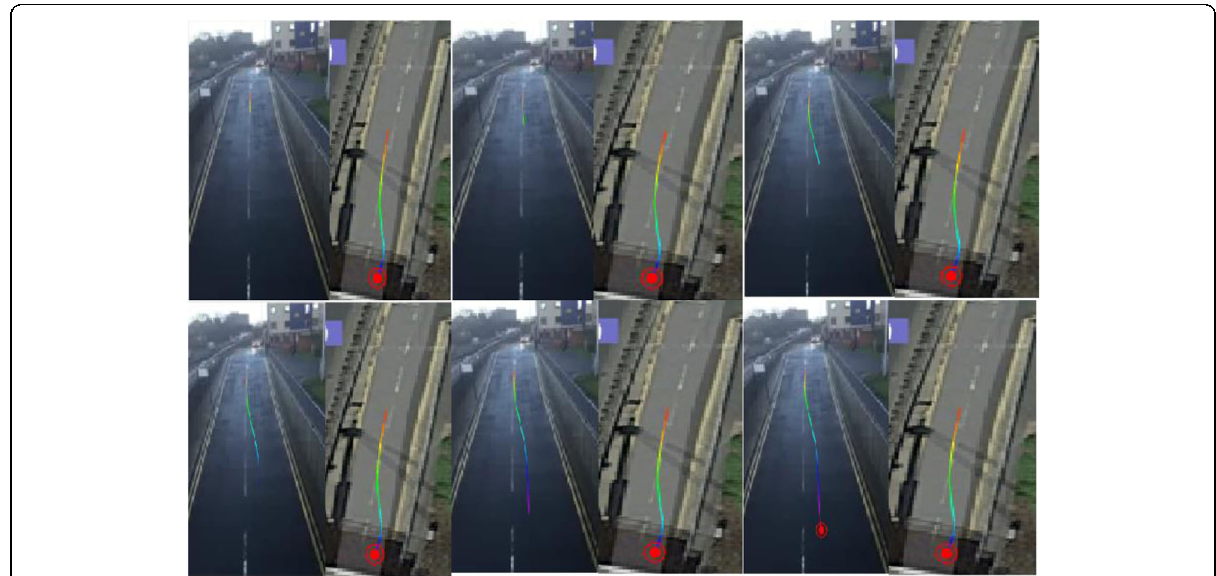
Fig. 22 Event detection and display on Google